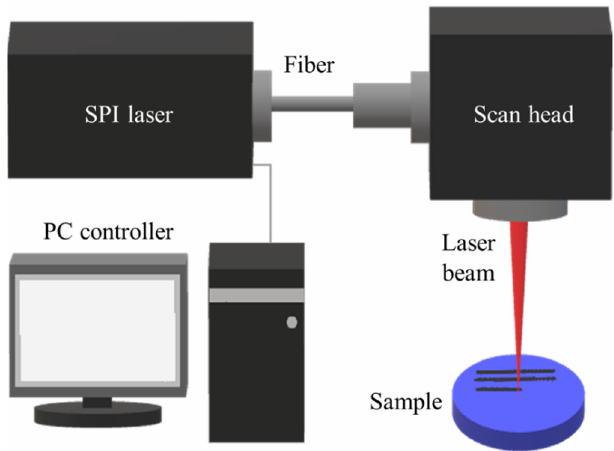
Figure 2. A schematic diagram of the laser